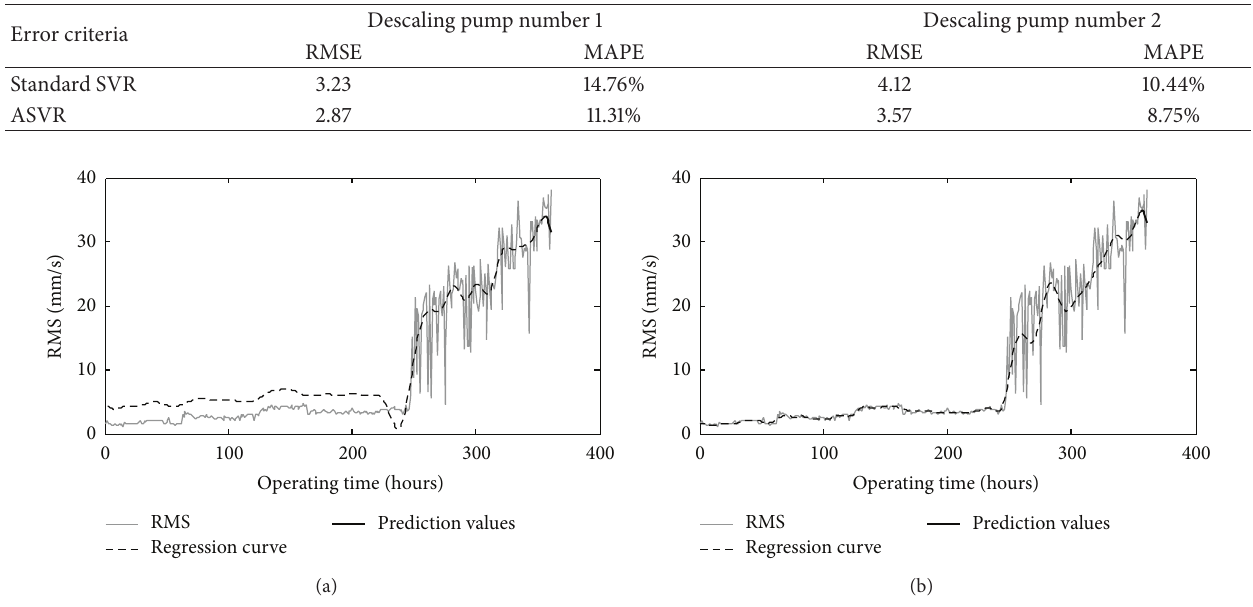
Table 2: Prediction errors of standard SVR and ASVR.